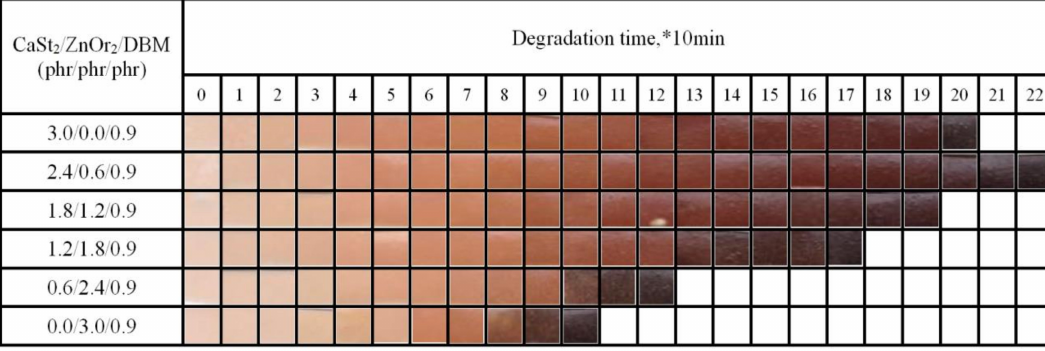
Figure 13. The effects of discoloration for PVC with different proportions of CaSt 2 /ZnOr 2 /DBM thermal stabilizers at 180 ◦